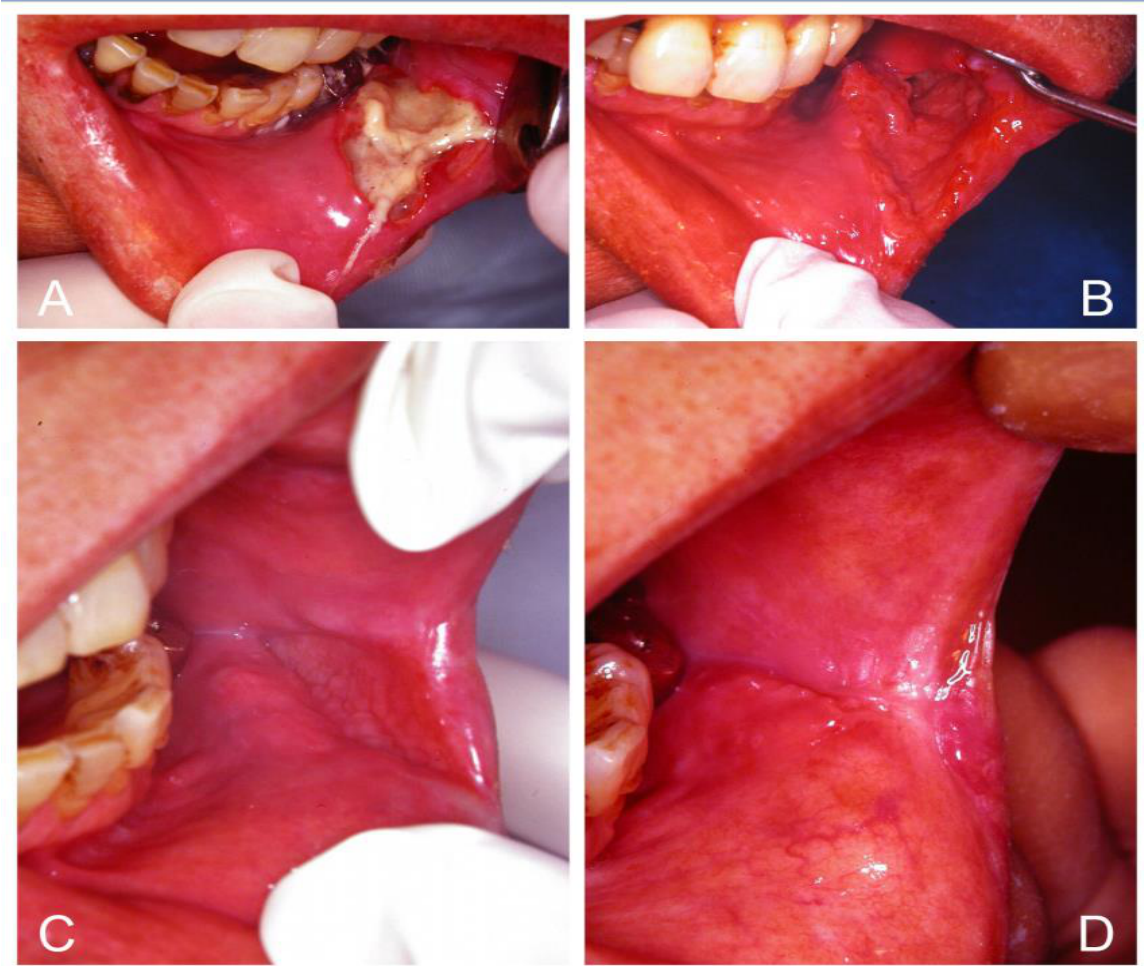
Figure 7. ( A ) Suppurative candidosis resulting in a deep necrotic oral ulcer with facial cellulitis-like dermis infection and fever in a 64-year-old woman with nephrotic syndrome who was refractory to broad-spectrum antibiotic therapy for 5 days. ( B – D ) Successful management was achieved by local debridement and prescription with fluconazole 1 week later ( B ), 3 weeks later ( C ), and complete response within 4 weeks ( D ).